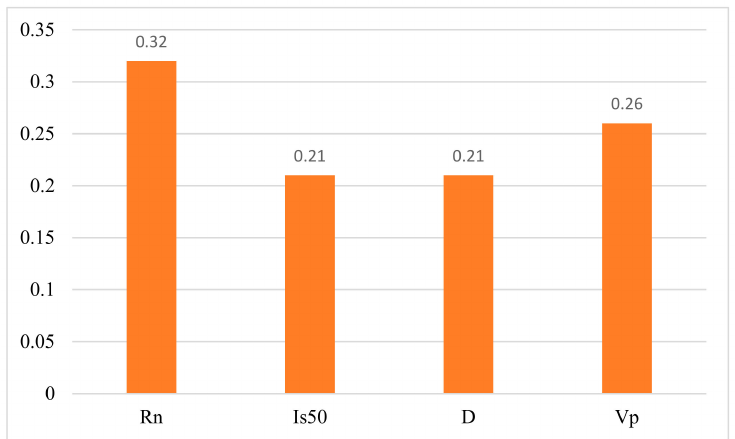
Figure 13. Input variable’s importance to predict the BI derived from the KNN